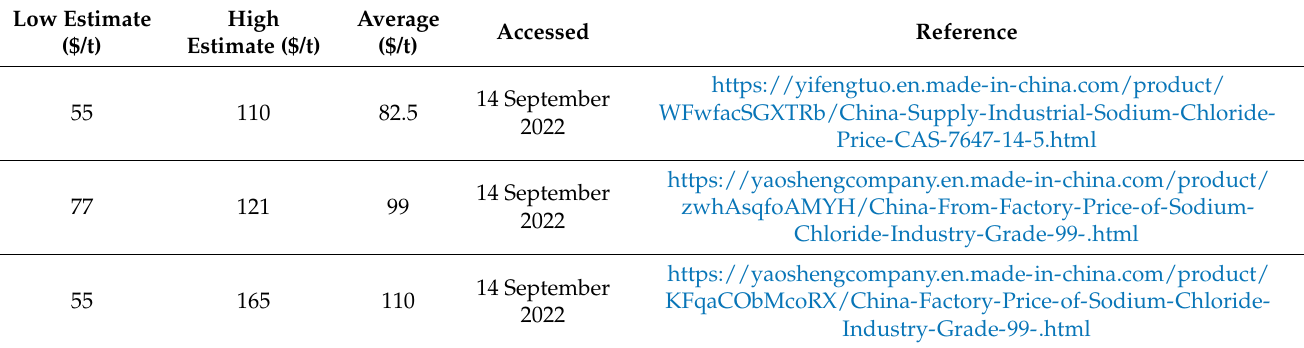
Table A4. Bulk Vendor Costs for